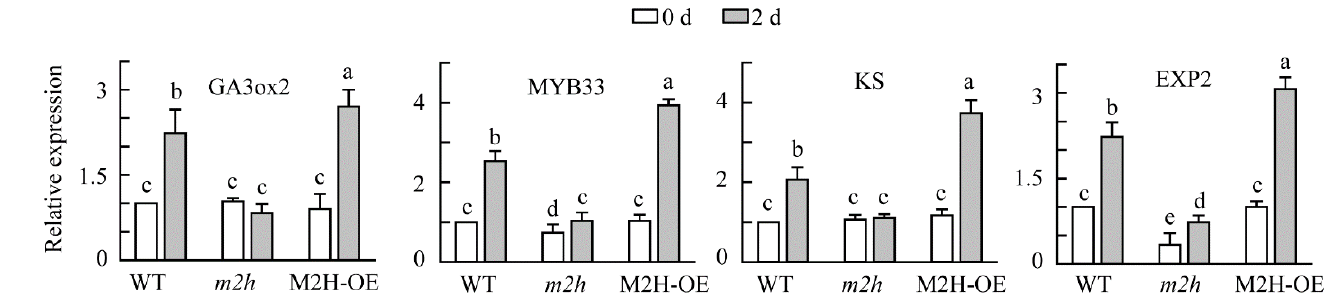
Figure 5. Reverse transcription quantitative real-time PCR (qRT-PCR) analysis results for genes involved in germination in various Arabidopsis thaliana lines. The relative expressions of GA3ox2 , KS , MYB33 , and EXP2 in non-dormant WT, m2h knockout, and M2H-OE seeds were measured at 0 and 2 days after imbibition. Expression levels were normalized to 18s rRNA . Different letters indicate significant differences ( p < 0.05; ANOVA, followed by Tukey’s HSD post hoc tests). GenBank